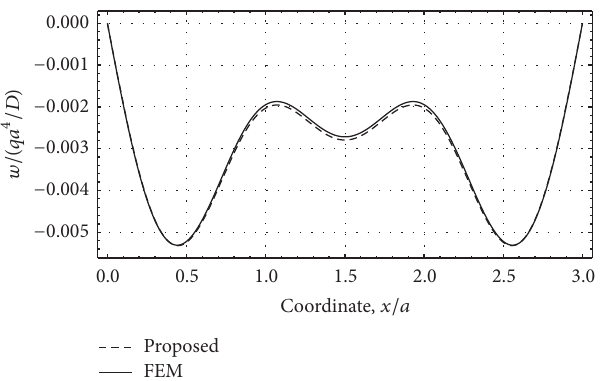
Figure 9: Deflection, 𝑤 , along the line at 𝑦 = 1.5𝑎 .